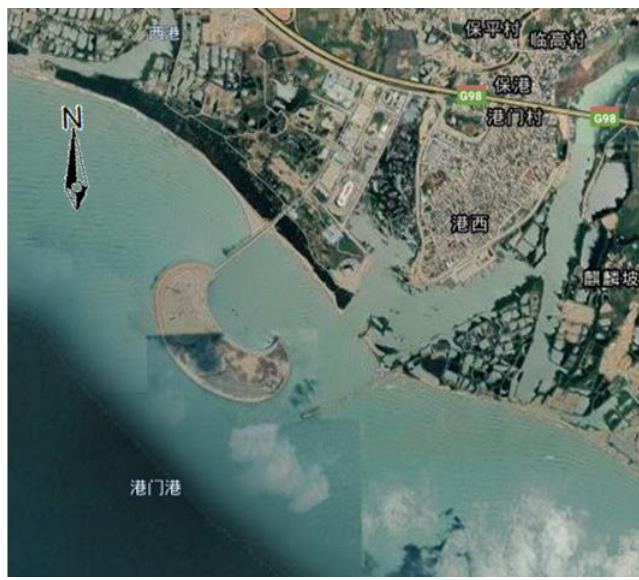
Figure 8. Range of the MIKE 21 BW model.